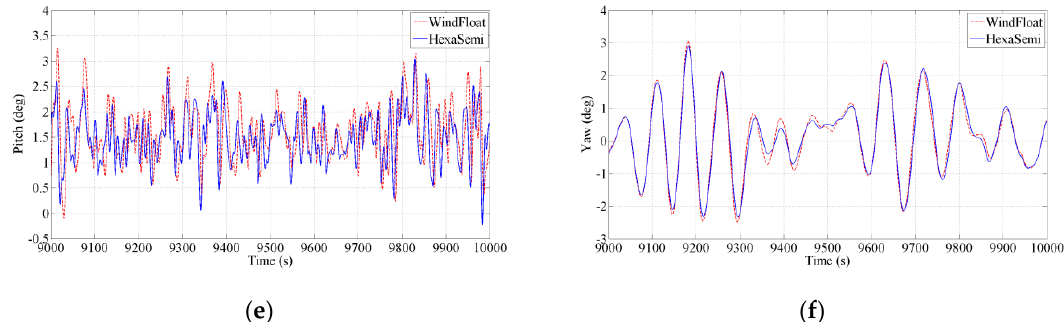
Figure 10. 6-DOFs motion response under the operational condition: ( a ) surge, ( b ) sway, ( c ) heave,